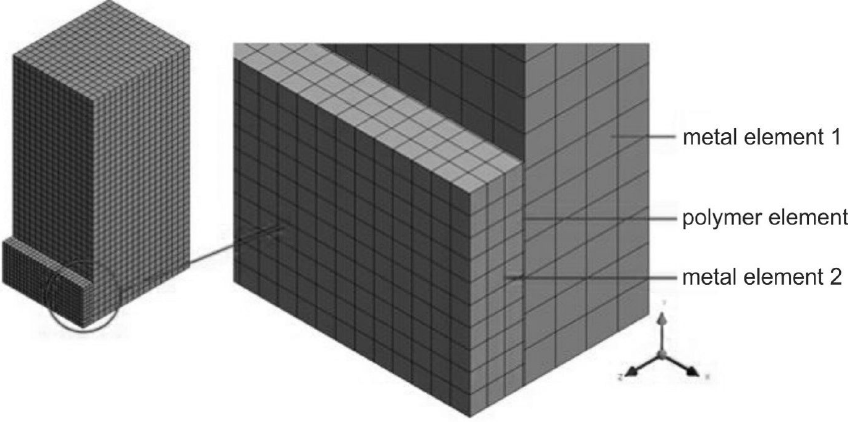
Figure 8. Three-dimensional (3D) model no. 1: specimen with an adhesively bonded cuboid element.